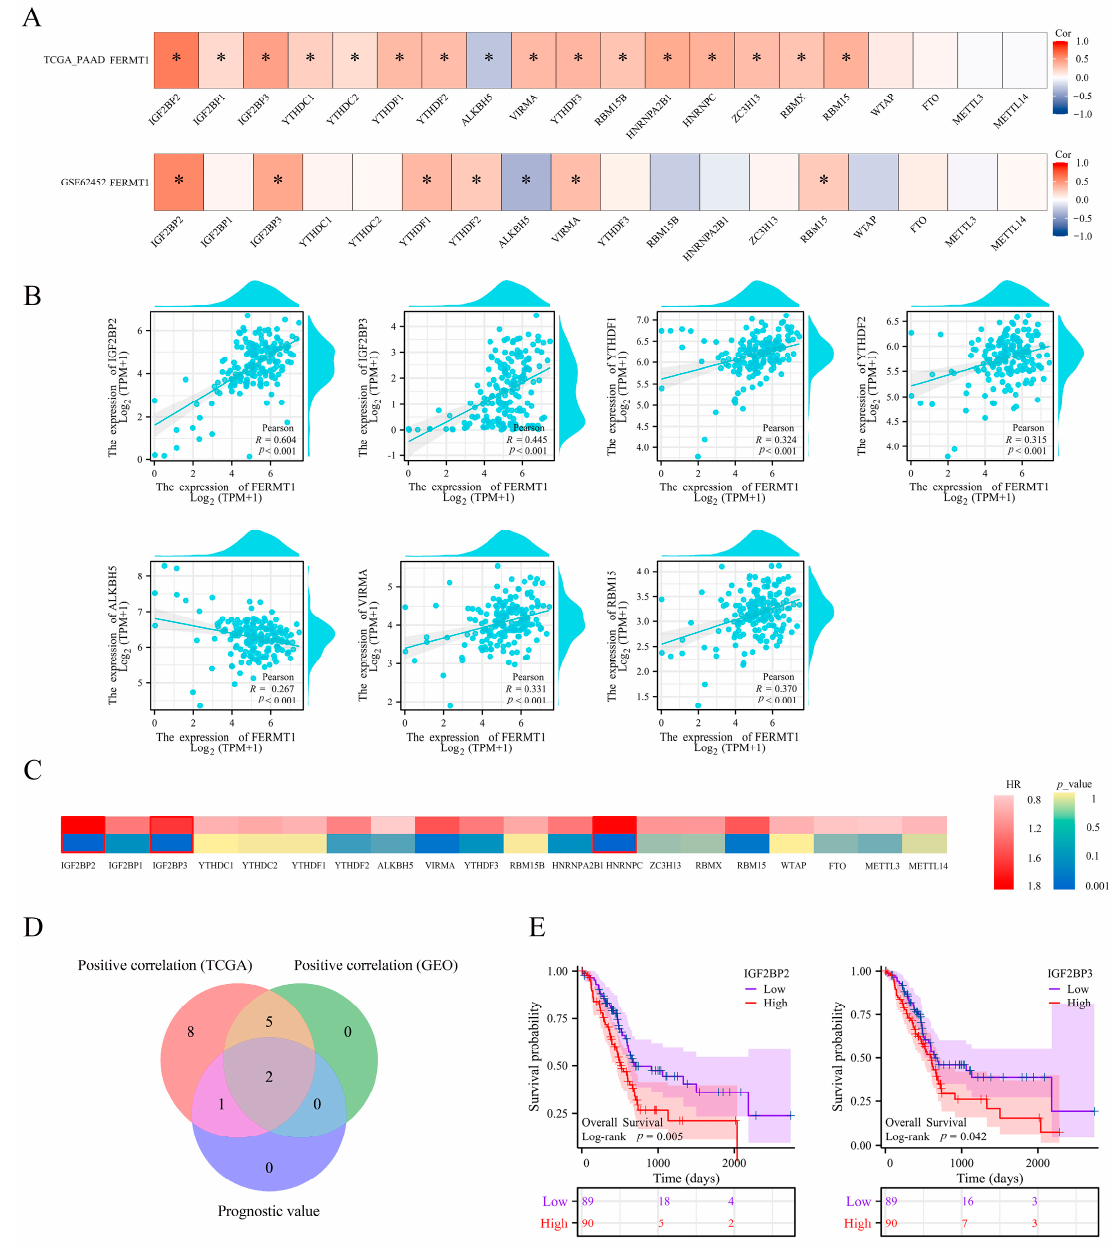
Figure 5. Correlation analysis of FERMT1 expression with m 6 A-related genes in PAAD. ( A ) Cor- relation between FERMT1 and m 6 A-related gene expression in PAAD was analyzed using the TCGA-PAAD and GSE62452 datasets. ( B ) The correlation between FERMT1 and the expression of m 6 A-related genes were described using scatter plots, including IGF2BP2 , IGF2BP3 , YTHDF1 , YTHDF2 , ALKBH5 , VIRMA and RBM15 . ( C ) Prognostic heatmap of m 6 A-related genes. ( D ) Venn diagram showed common genes with positive correlation and prognosis. ( E ) Kaplan-Meier curves of IGF2BP2 and IGF2BP3 . * p < 0.05.